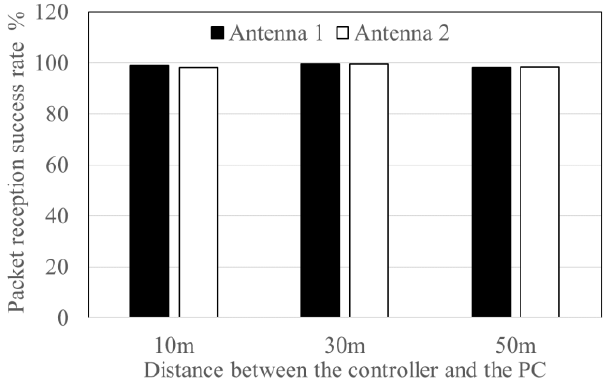
Figure 6. Average packet reception success rate in each communication distance: The black bar is the antenna 1’s results, and the white bar is the antenna 2’s results, respectively.